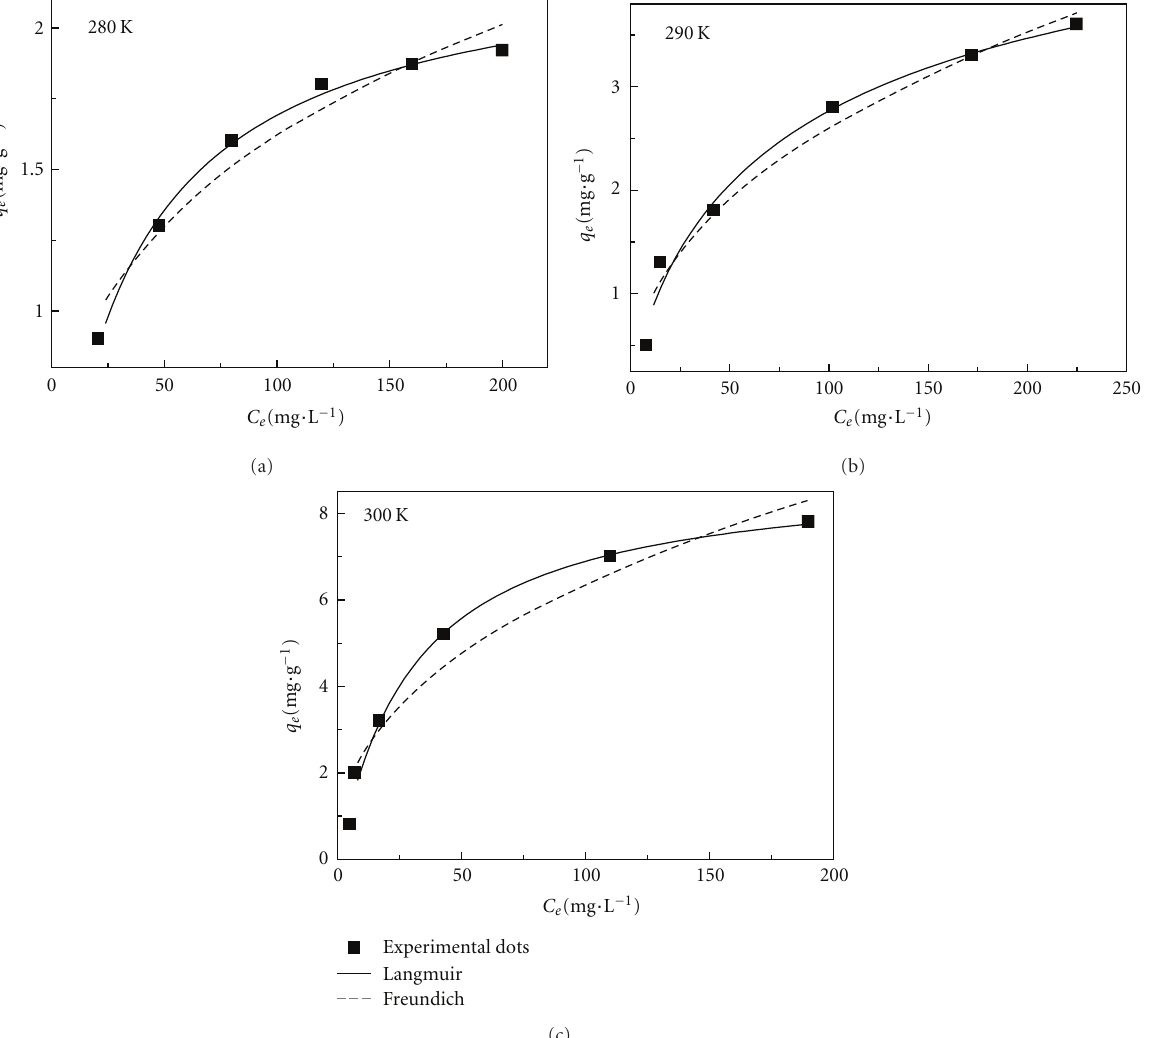
Figure 4: Equilibrium isotherms of CNT-CNF film electrodes in CuCl 2 solution at (a) 280K, (b) 290K and (c) 300K.